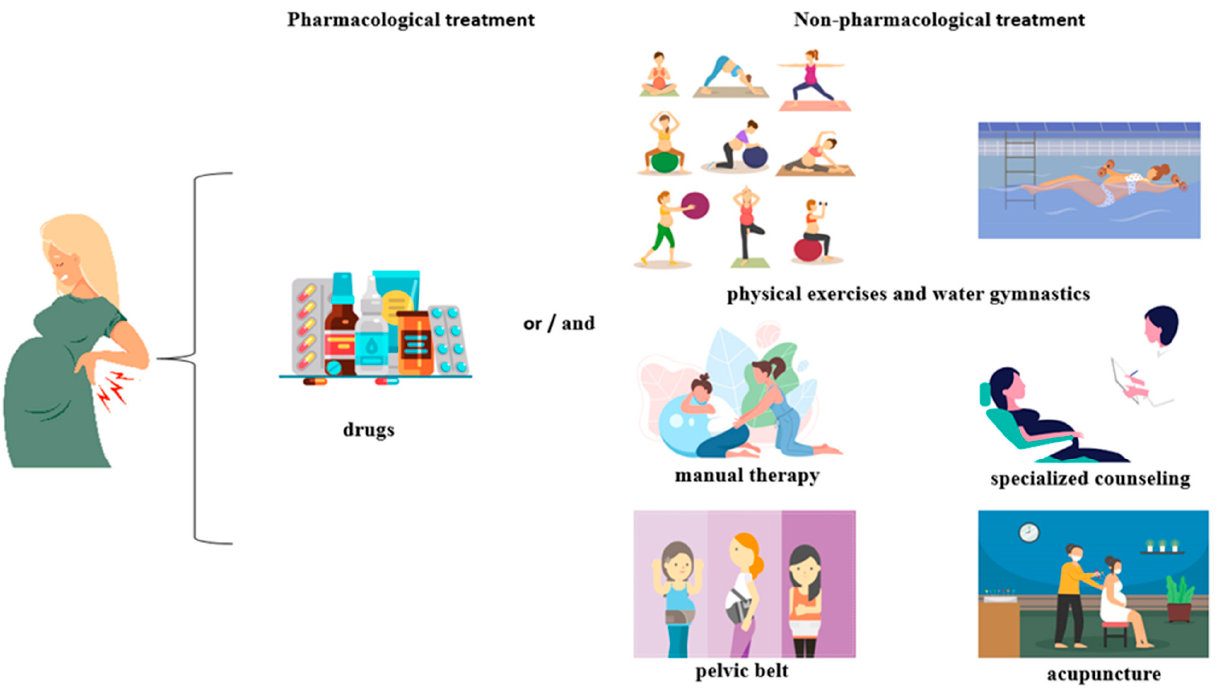
Figure 6. Pharmacological and non-pharmacological treatment of pain in pregnant women.